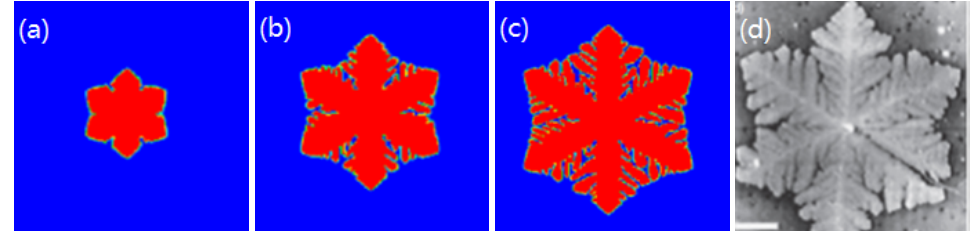
Figure 3. When K 0 = 1.25, the morphology of dendrites is obtained by numerical simulation. (( a – c ) are the numerical simulation results with time iteration steps of 1000, 2000 and 3000, respectively. ( d ) is the experimental result).